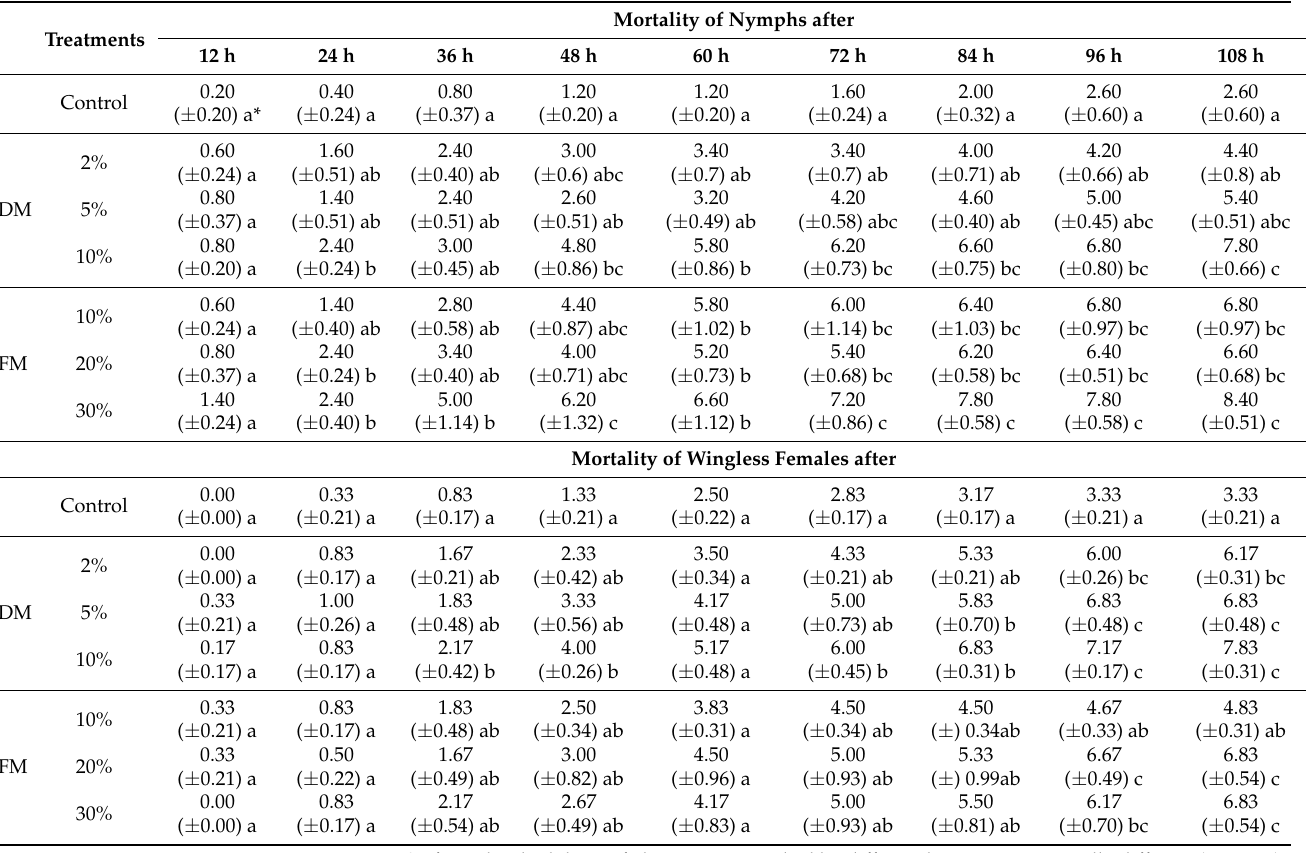
Table 2. Mortality of the Aphis fabae Scop. nymphs and wingless females [mean number of dead individuals out of ten at the beginning of the experiment] feeding on broad bean leaves after the application of water extracts made from fresh (FM) and dried (DM) parts of